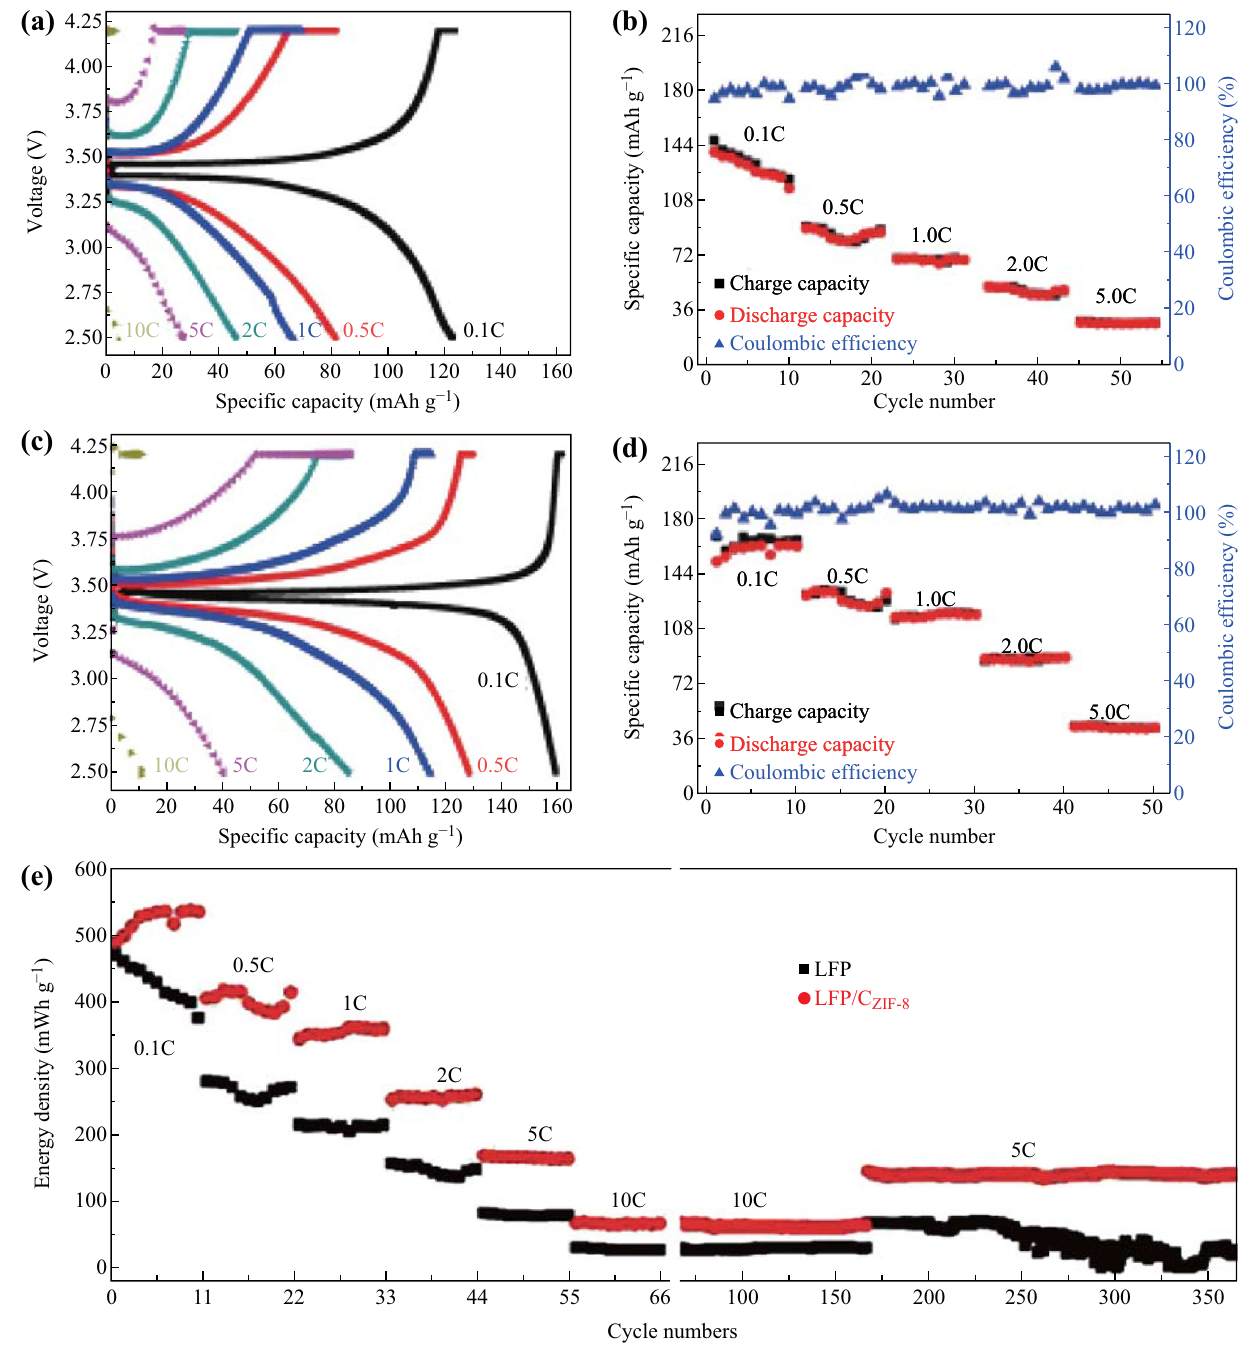
Fig. 6 First charge-discharge curves of the LIBs with the a LFP and c LFP/C ZIF-8 at different rates. Capacity retention and Coulombic efficiency of the LIBs with the b LFP and d LFP/C ZIF-8 for 50 cycles at different rates. e The discharge specific energy of different cathode samples for 10 cycles at 0.1–10.0C rates, respectively, then for 100 and 200 cycles at 10.0 and 5.0C rates,